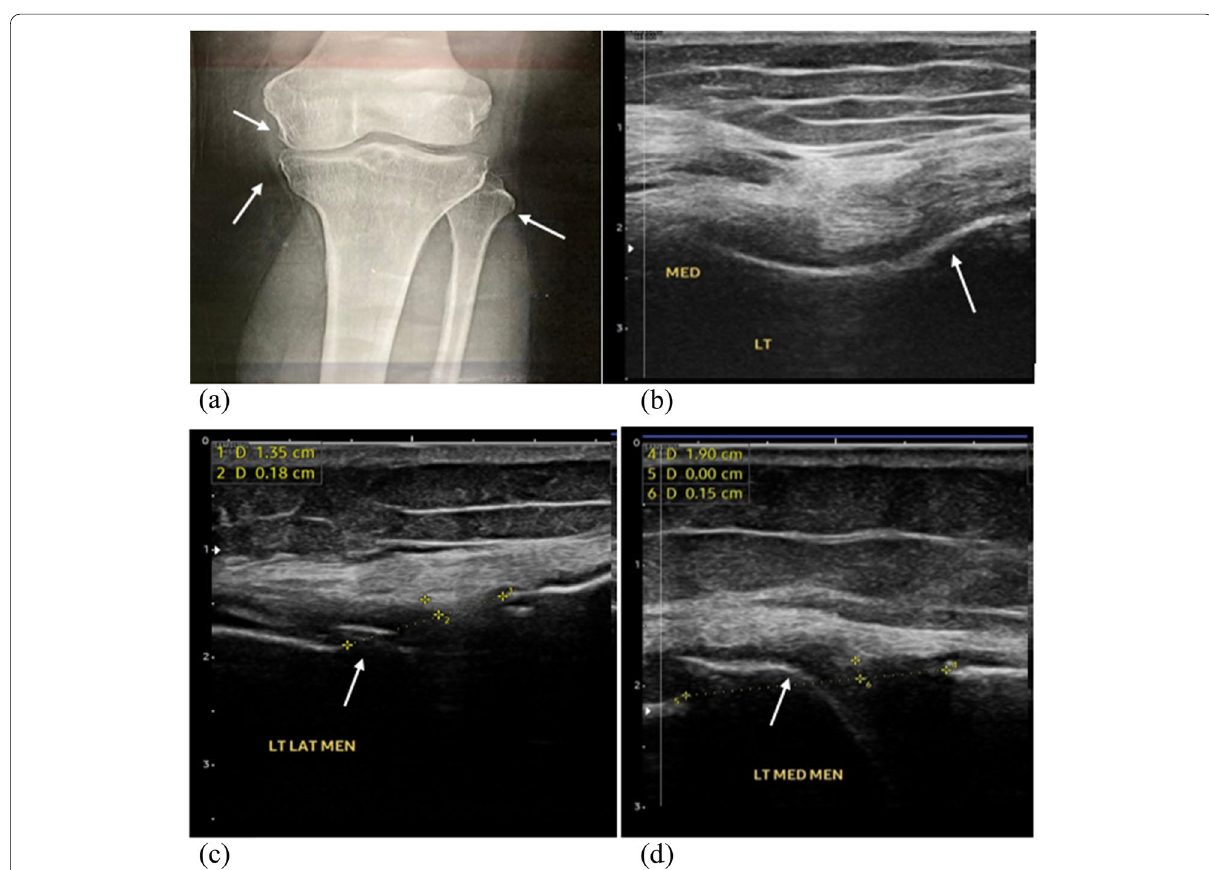
Fig. 1 a Plain X‑ray of left knee joint anteroposterior 48 years old female patient showing grade 2 KL grading with presence of definite osteophytes and possible joint space narrowing. Sonographic assessment showed b global femoral cartilage (GFC) semi‑quantitative grading G2b with loss of normal cartilage interfaces sharpness and increased echogenecity of the cartilage together with local thinning (> 50% but < 100% of the catilage), c lateral medium osteophyte grade 2 and lateral menicial extrusion measuring 1.8 mm, and d medial large osteophyte grade 3 and medial meniscial extrusion measuring 1.5